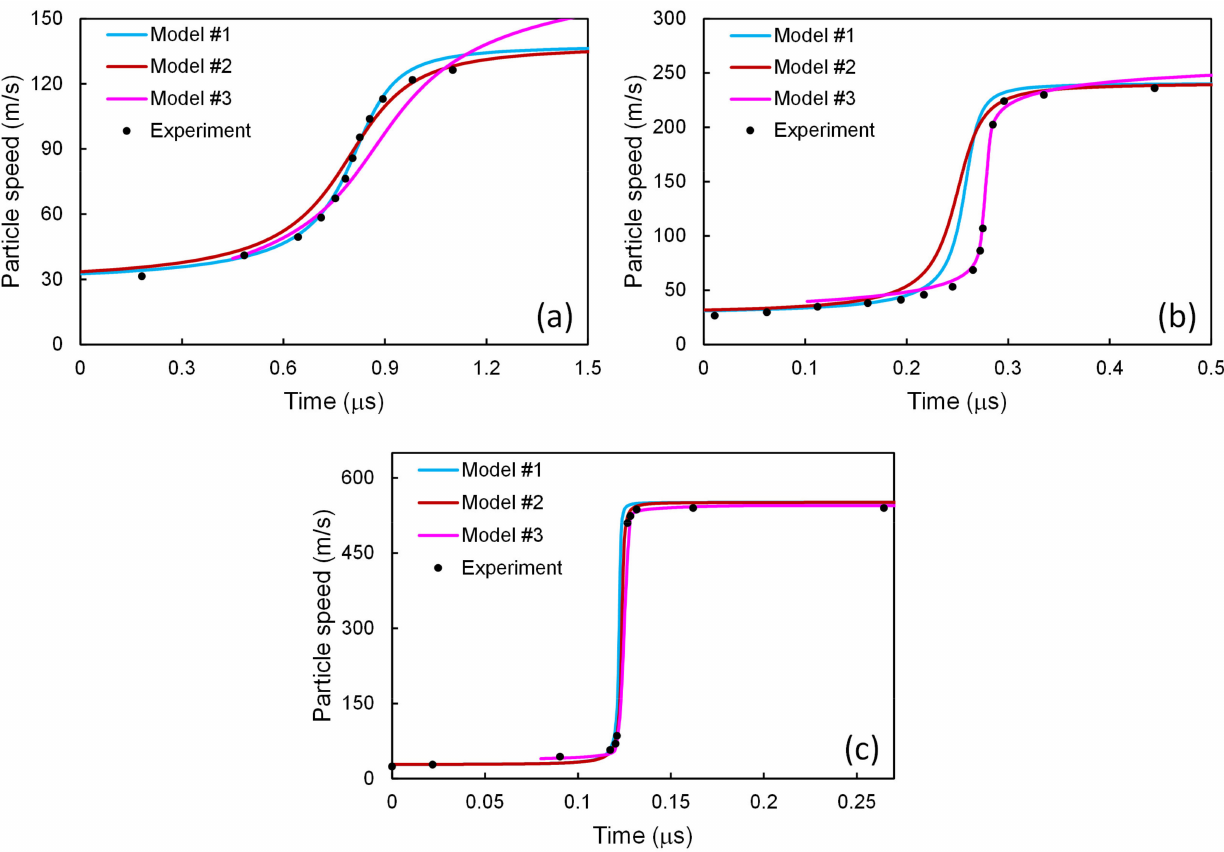
Figure 8. Particle speed profiles for 6061-T6 Al alloy at shock stress amplitudes of ( a ) 2.1, ( b ) 3.7, and ( c ) 9.0 GPa. The results of the three models [2,4,22] are compared with the experimental ones